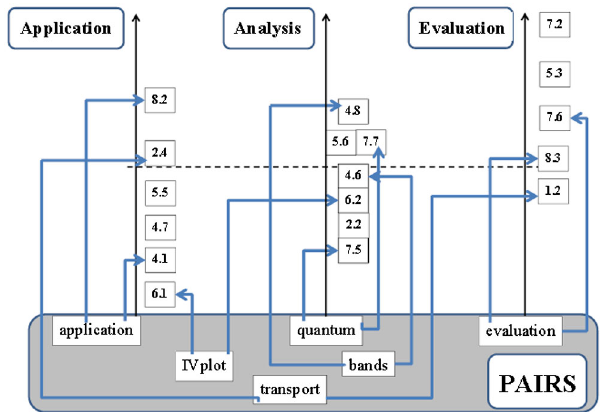
FIG. 7. Subsets in the PSCI-BETA-Instrument. The items in each subset are represented in the increasing order of their difficulty. The horizontal dashed line stands for the zero-logit median difficulty. The shaded box PAIRS contains the labels of the six pairs of items. The items paired together are indicated by arrows starting from that pair ’ s label in the shaded